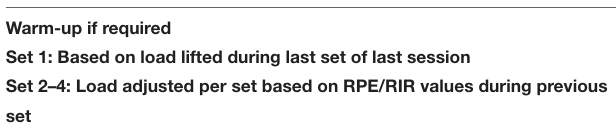
TABLE 4 | Theoretical load adjustment during autoregulated tendinopathy heel-raise resistance training based on the representation of rating of perceived exertion and corresponding repetitions in reserve